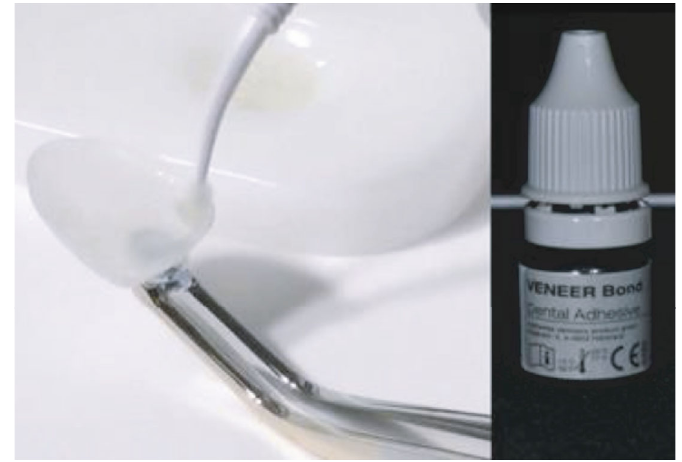
Figure 8: Veneer Bond application.